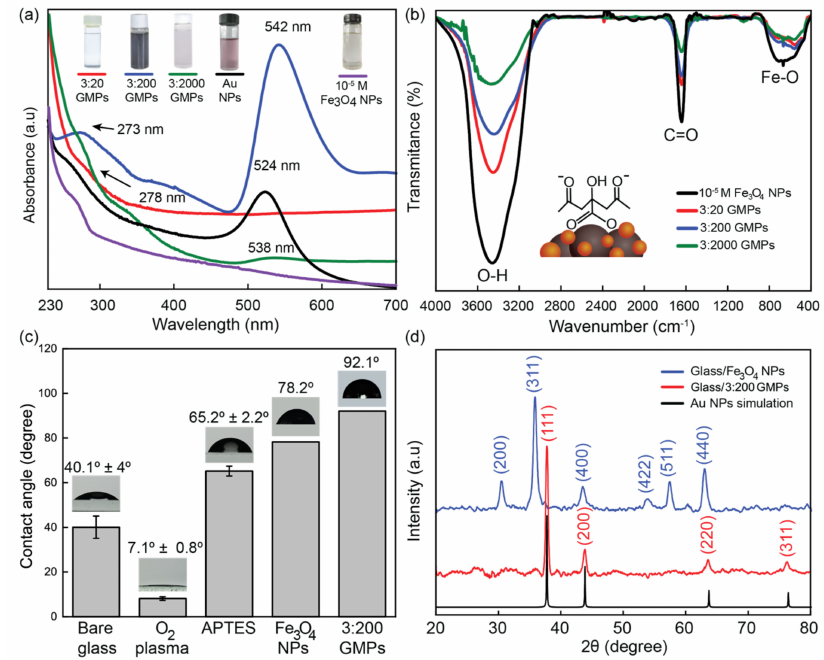
Figure 3. ( a ) The UV-Vis spectra of 10 − 5 M Fe 3 O 4 NPs and GMPs with various ingredient ra- tios compared to Au NPs, (Adapted with permission from Ref. [33]. Copyright 2020, RSC). ( b ) The FTIR spectra of 10 − 5 M Fe 3 O 4 NPs and GMPs with different ingredient ratios. ( c ) The water contact angle, with images of the interface between a water drop and the modified surface at each step. ( d ) The XRD pattern of the Fe 3 O 4 NPs and the 3:200 GMPs on glass compared to the Au NP simulation (JCPDS file: